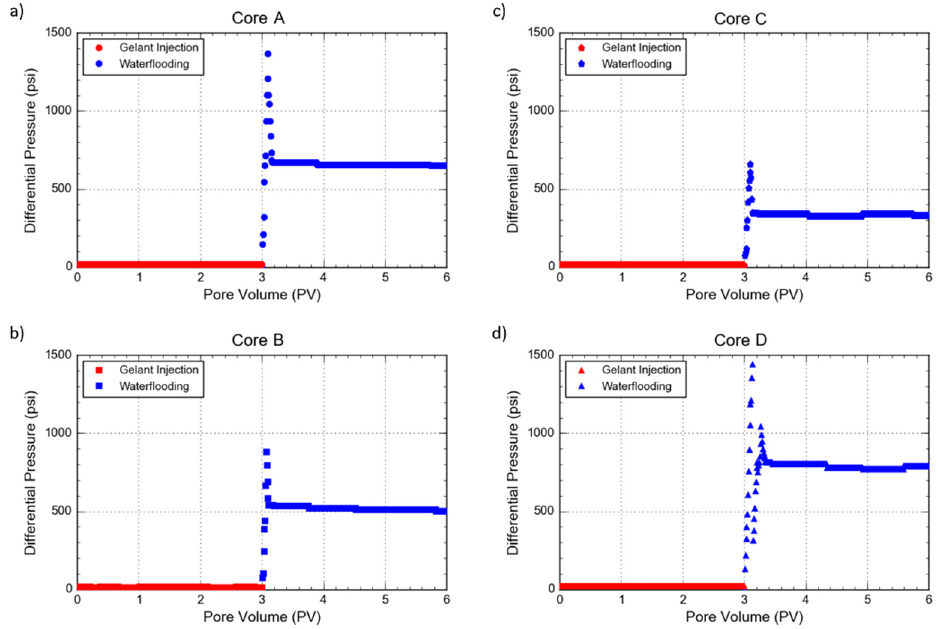
Figure 11. Differential pressure as a function of pore volume in the coreflooding experiments with- out crossflow effect in Core A ( a ), Core B ( b ), Core C ( c ) and Core D ( d ). crossflow effect in Core A ( a ), Core B ( b ), Core C ( c ) and Core D ( d